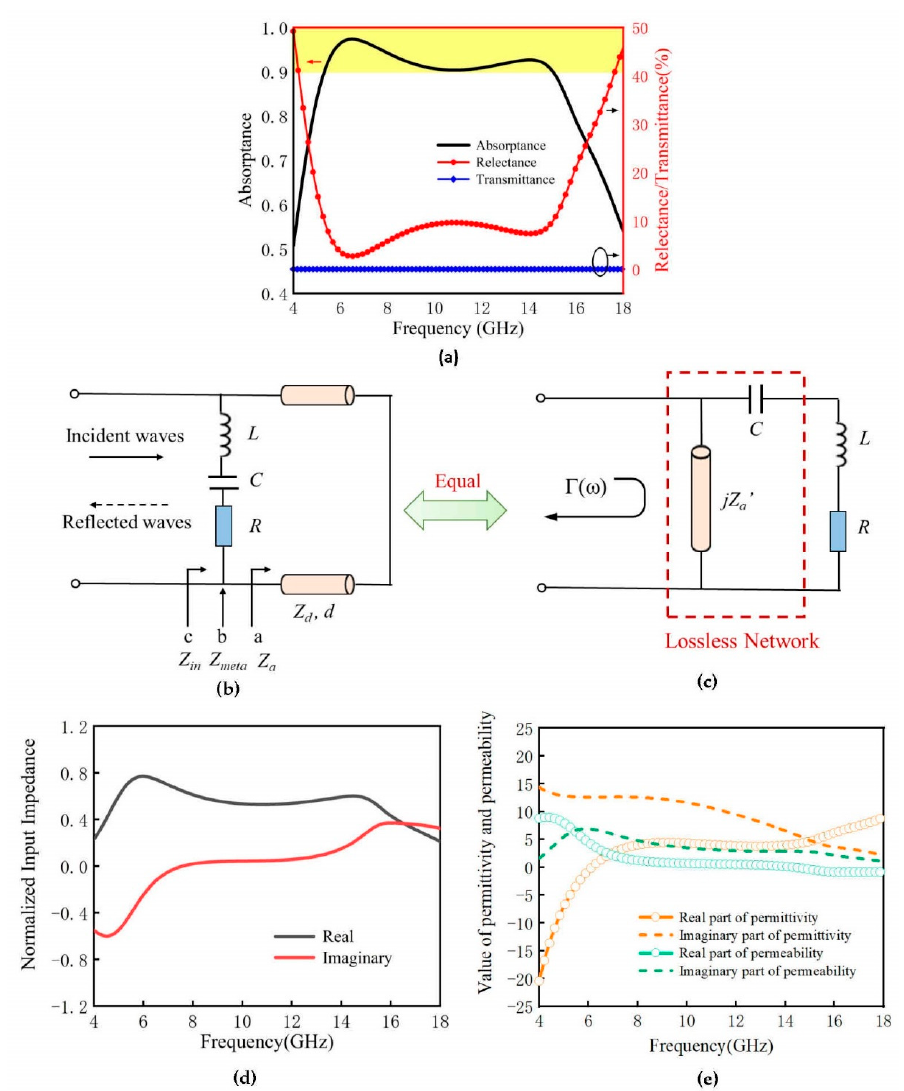
Figure 3. ( a ) Microwave-range characteristics of FTBMA under normal incident TE plane wave irradiation conditions. ( b ) The equivalent circuit model of FTBMA. ( c ) The circuit of series RL loads matched with passive and lossless networks. ( d ) Normalized input effective impedance of FTBMA. ( e ) Frequency-dependent spectra of retrieved effective electromagnetic parameters of FTBMA.